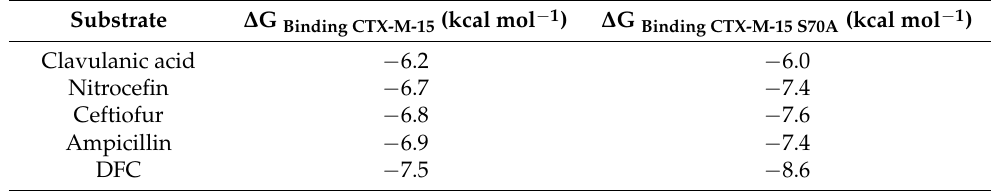
Table 4. Binding free energies calculated by molecular